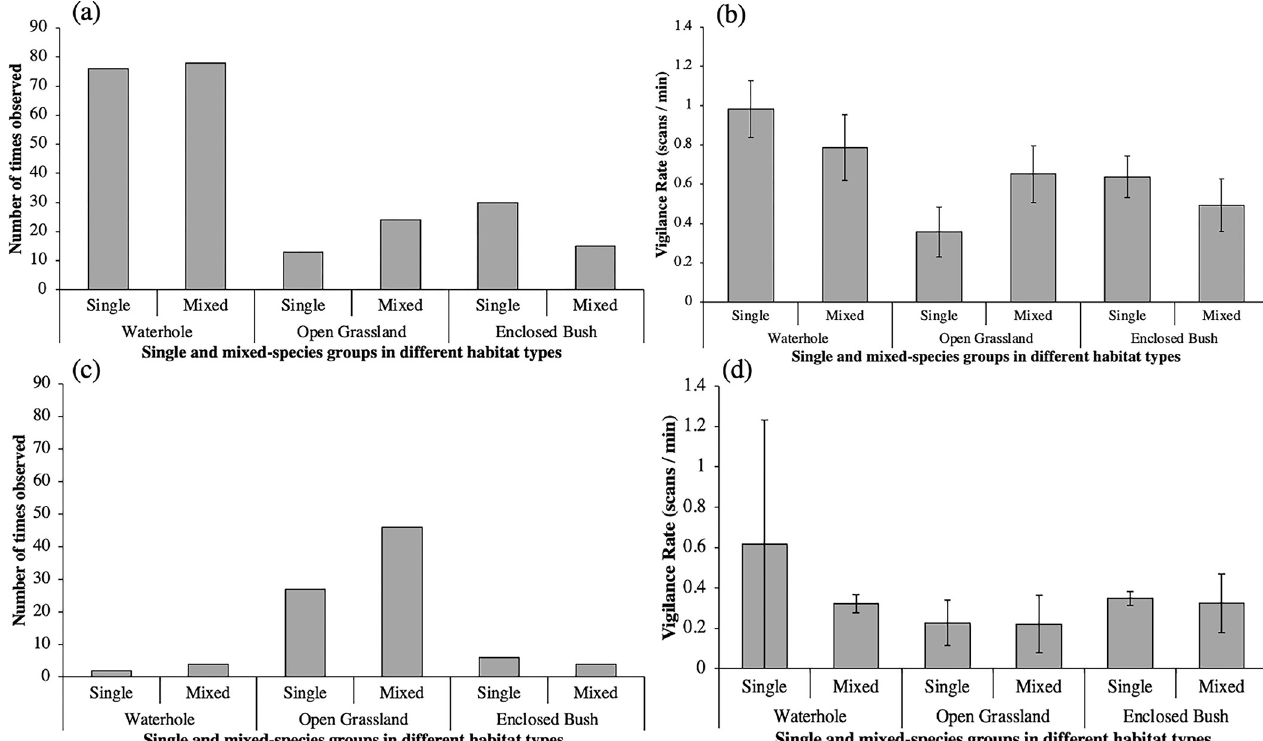
Fig 6. (a) Number of times animals were observed in single and mixed species groups within each habitat type, and (b) rates of vigilance displayed across these different environments.